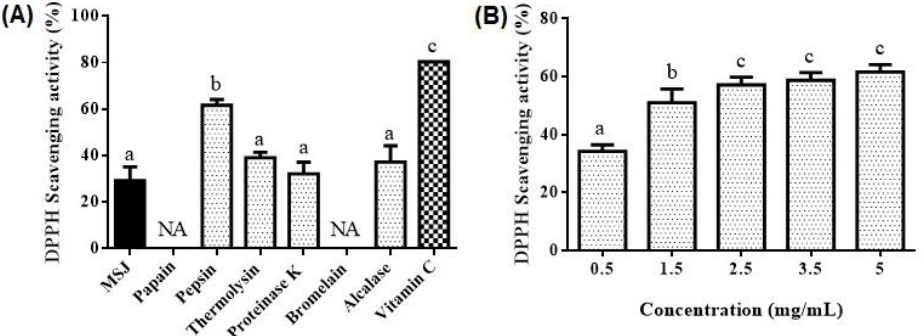
Figure 8B. The increasing of hydrolysates concentration produced better DPPH radical scavenging activity. However, pepsin hydrolysates at 2.5 mg/mL did not significantly possess better activity than those at 3.5 mg/mL and 5 mg/mL ( p > 0.05) showing that protein concentration of 2.5 mg/mL, 3.5 mg/mL and 5 mg/mL scavenged DPPH radicals in the same capacity.